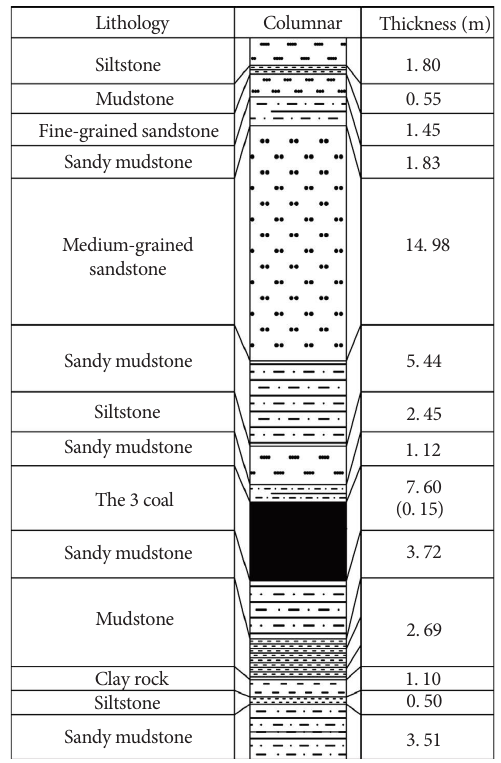
Figure 2: Comprehensive columnar section of the coal